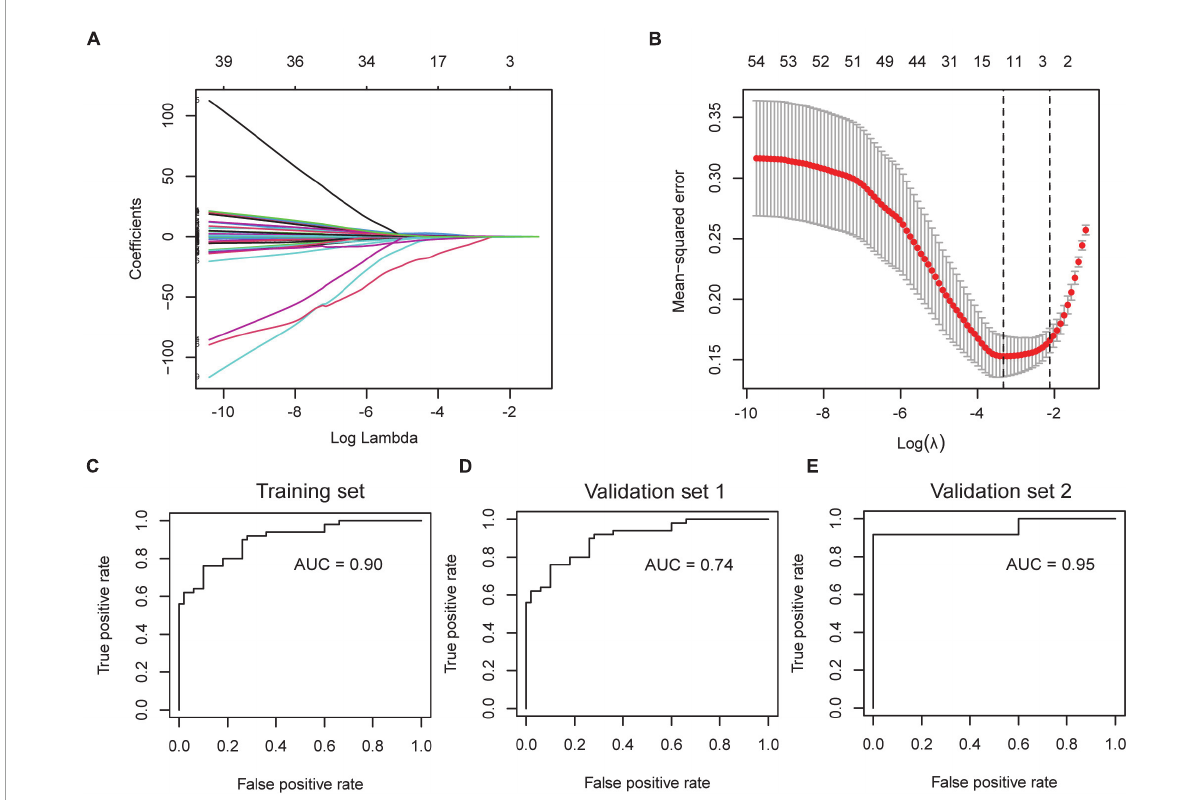
FIGURE8 Construction and verification of severity assessment model. (A,B) The screened severity-related genes were incorporated into the Lasso regression model and penalties were applied for preventing the overfitting effects of the model. (C) The ROC curve of the training set used to distinguish the severity of COVID-19. (D,E) The ROC curve of validation set 1 and validation set 2 used to distinguish the severity of